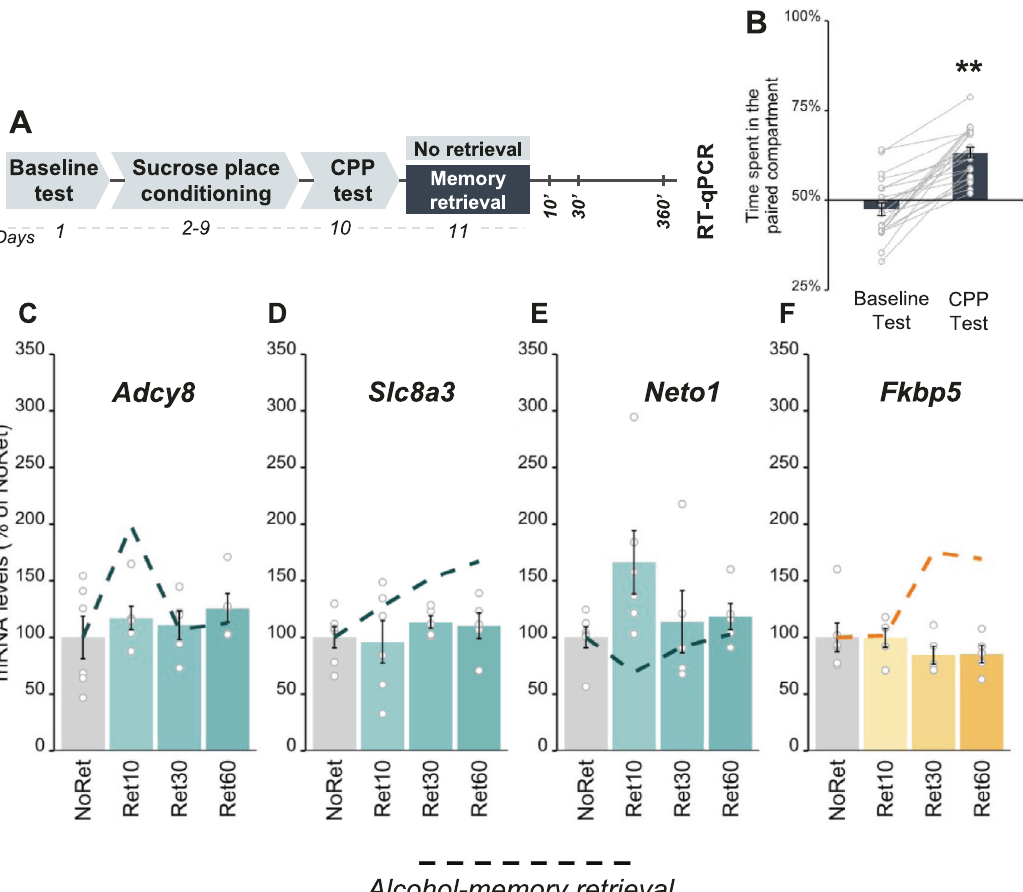
Fig. 6 Sucrose memory retrieval does not alter the expression of Adcy8 , Slc8a3 , or Neto1 in the dorsal hippocampus or of Fkbp5 in the medial prefrontal cortex. A Schematic illustration of the experimental design and timeline. B Place preference scores, expressed as means ± S.E.M. of the percent of time spent in the sucrose-paired compartment (t (21) = 8.45, p < 0.0001); C – F mRNA levels, normalized to Gapdh , expressed as means ± S.E.M. of the percent of change from the control group (No Retrieval). qRT-PCR analysis did not reveal differences in the mRNA levels of Adcy8, Slc8a3, or Neto1 ( A – C ), and Fkbp5 ( D ) in the DH and mPFC, respectively, between the Retrieval and No retrieval groups (one-way ANOVA; all p ’ s > 0.05). mRNA expression levels after alcohol memory retrieval (presented in Fig. 5E – H)) are shown as dashed lines; ** p < 0.01; n = 9 – 6 per